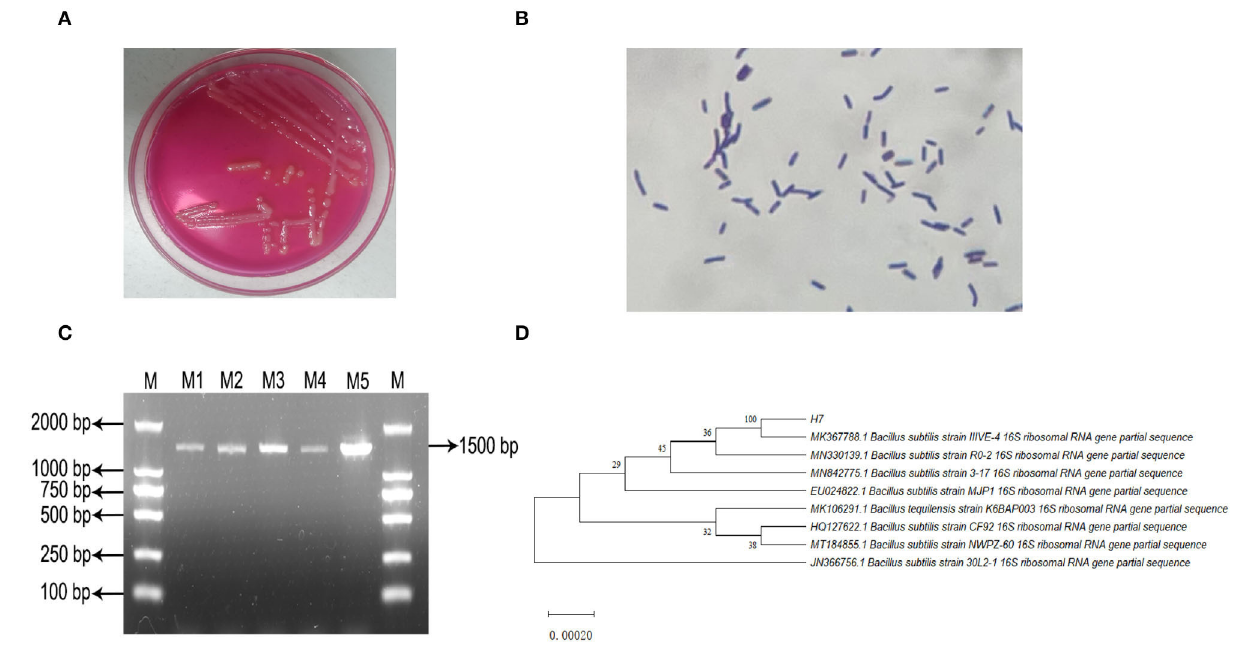
FIGURE 1 | Isolation, incubation and identification of Bacillus subtilis IIIVE-4. (A) Mannitol polymyxin plate colony morphology. (B) Gram staining test results. (C) PCR amplification product electrophoresis; M: DL2 000 Marker; M1 to M5: IIIVE-4 DNA amplification products. (D) phylogenetic tree; H7 is the Bacillus subtilis IIIVE-4 gene sequence; values of developmental tree nodes represent Bookstrap values; numbered values are the GenBank database accession